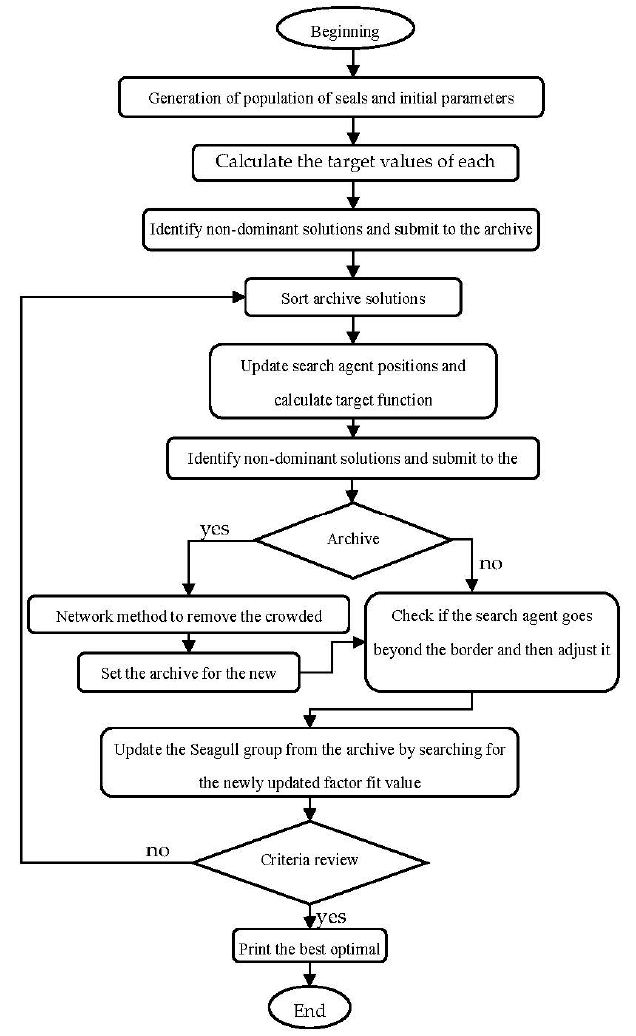
Figure 7. Flowchart of the proposed method in